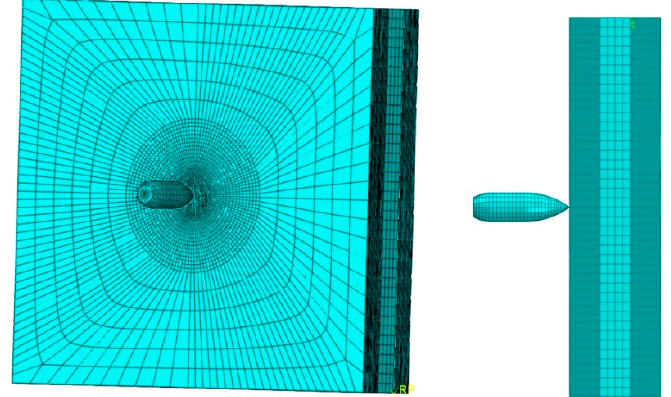
Figure 6. FEM mesh for the most complex variant (laminate ‐ glycol ‐ laminate).